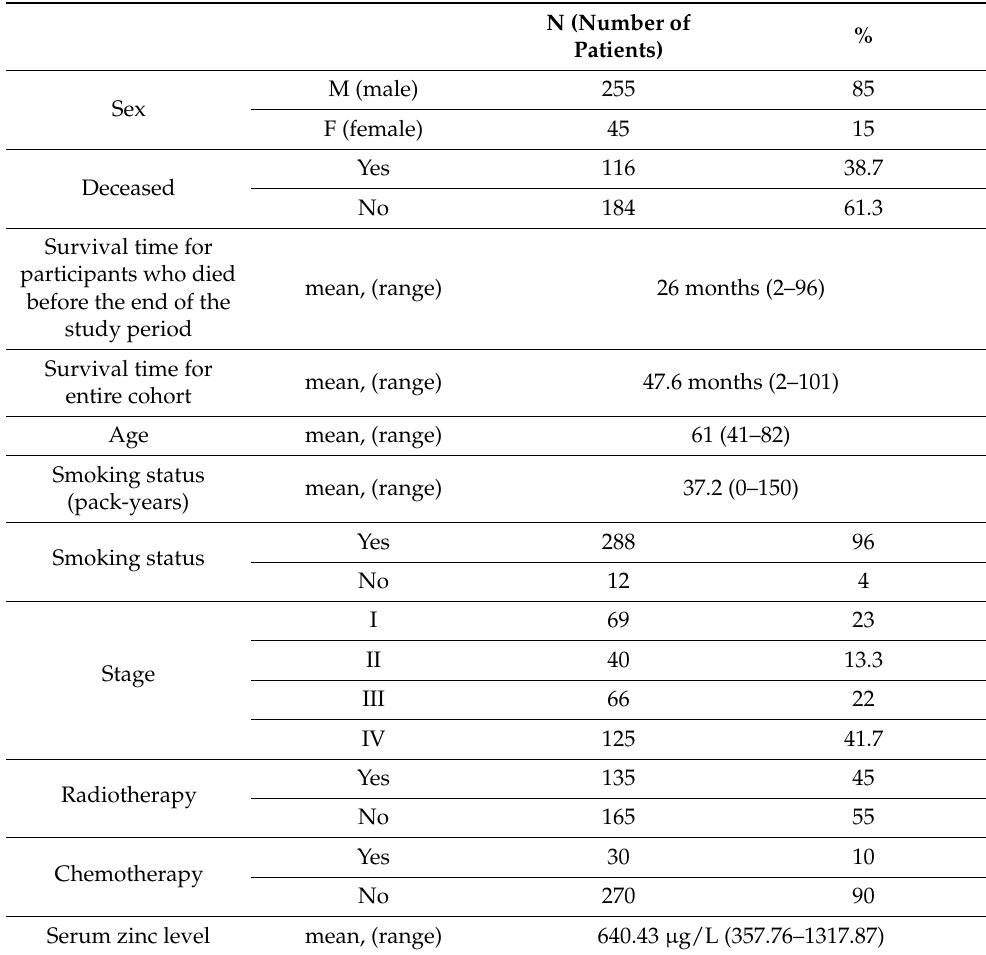
Table 1. Characteristics of the study population ( n = 300).